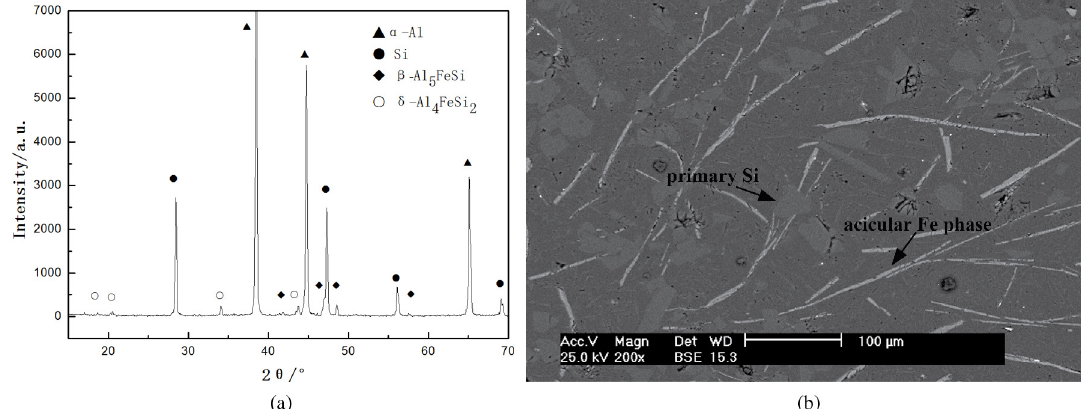
Figure 3. (a) XRD spectrum of CS casting A0 alloy; (b) Microstructures of CS casting A0 alloy: BSE microscopy.